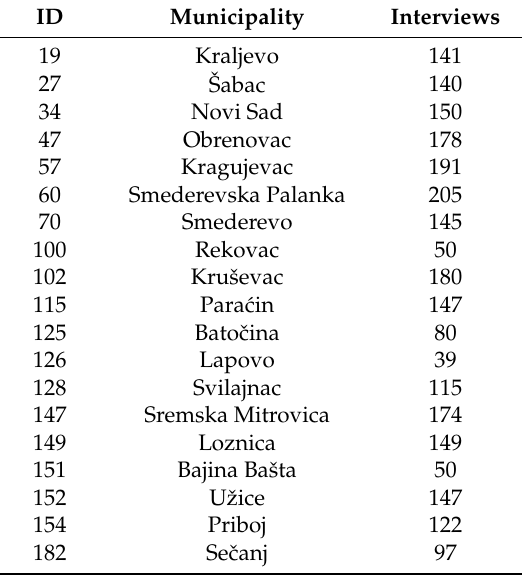
Table 1. Name and ID code of the municipalities involved in the survey. The number of interviews is also shown. The location of the municipalities involved and the complete table of all Serbian municipalities (with ID) are shown in the Supplementary Material (Figure S1; Table S1). ID